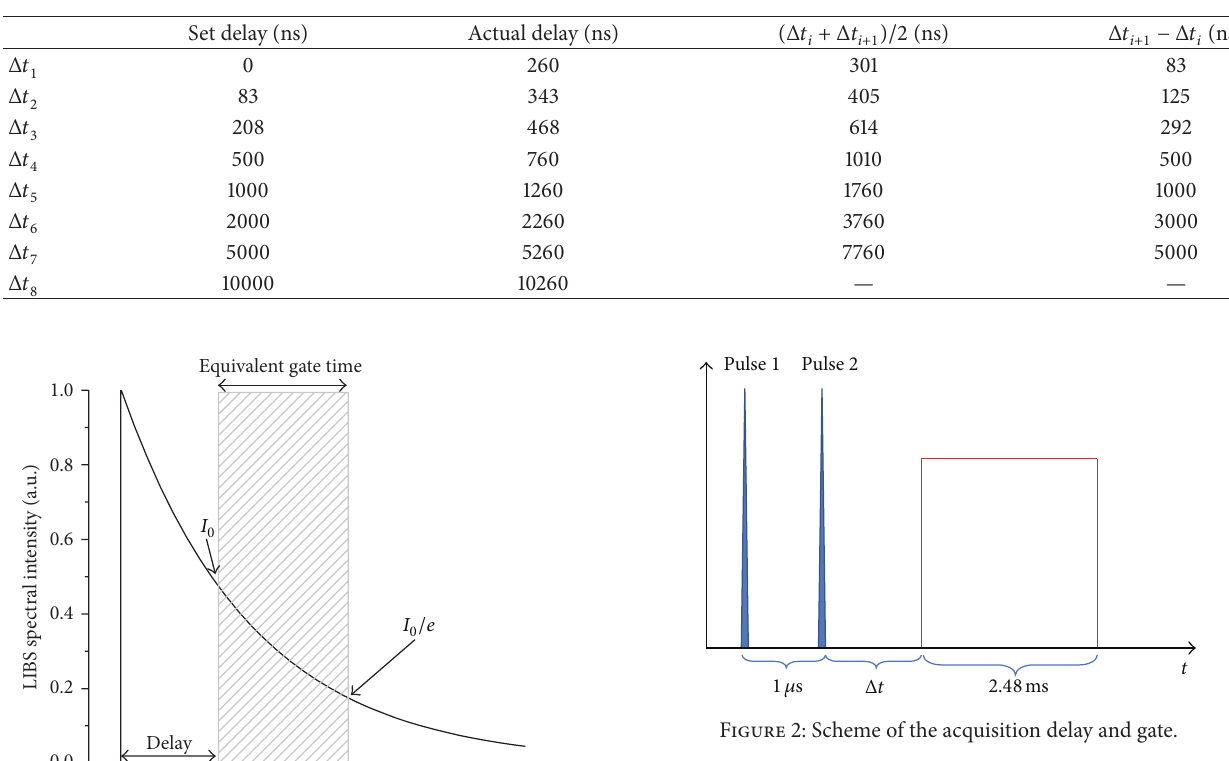
Table 1: Acquisition delays used in this work. An additional internal delay of 260 ns must be added to the set delay for obtaining the actual delay from the second laser pulse.